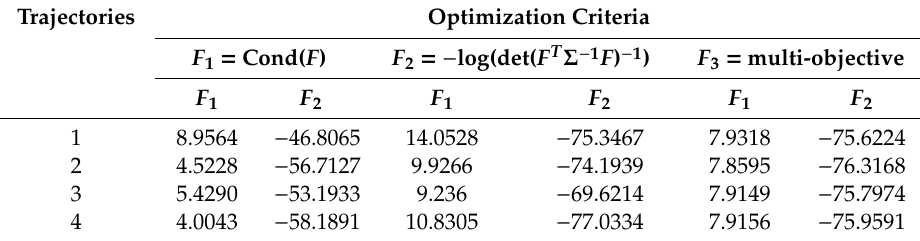
Figure 4. Random trajectory identification results for obtaining the noise characteristics. Table 2. Values of the objective function for the exciting trajectories.